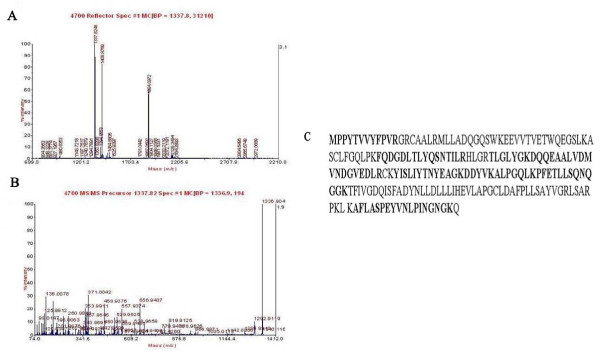
The MALDI-TOF-MS map of GSTP1 was shown in (A). B displayed the MS/MS spectra of peptide m/z 1337.82 of GSTP1, C displayed the amino acid sequences of GSTP1 in which matched peptide sequence was in bold, and the sequence coverage was 52%.